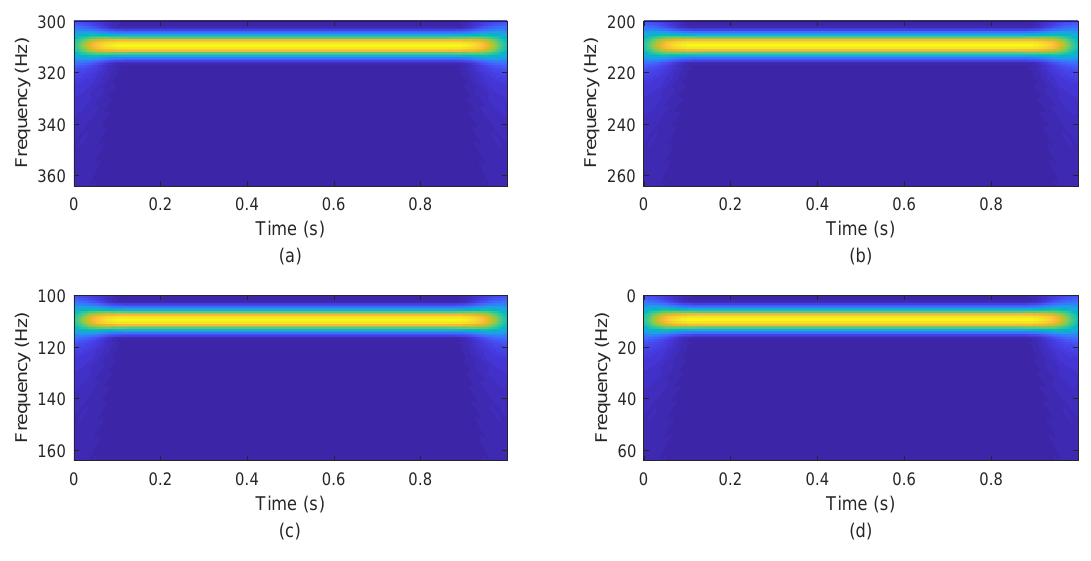
Figure 17. Separation signals’ frequency spectrum. Subfigures ( a – d ) show the frequency spectrums of separation signals ˆ s 1 , ˆ s 2 , ˆ s 3 , and ˆ s 4